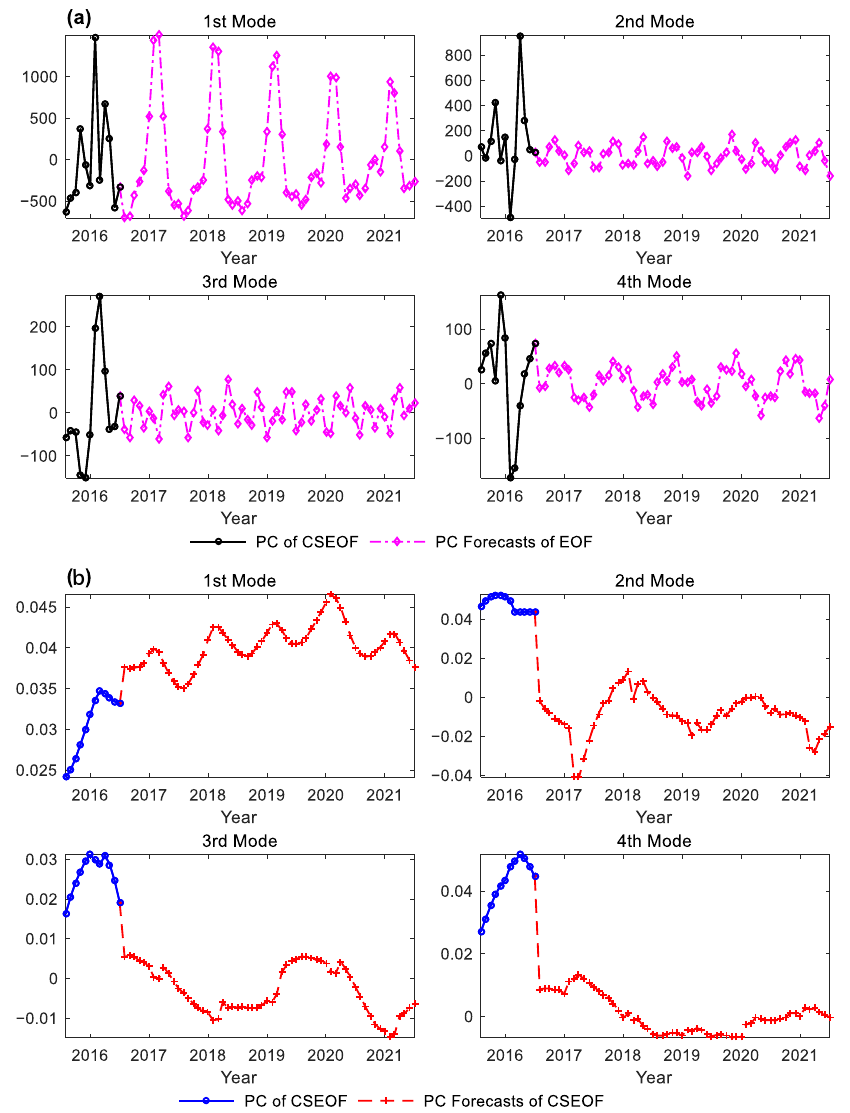
Figure 9. Forecasts of principal component time series based on EOF and CSEOF analysis. ( a ) PC forecasts of EOF – ARIMA, ( b ) PC forecasts of CSEOF – ARIMA.